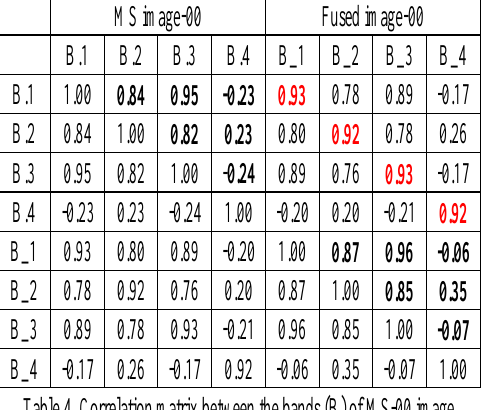
Table 4. Correlation matrix between the bands (B) of MS-00 image (B.1-B.4) and fused image-00 (B_1-B_4).